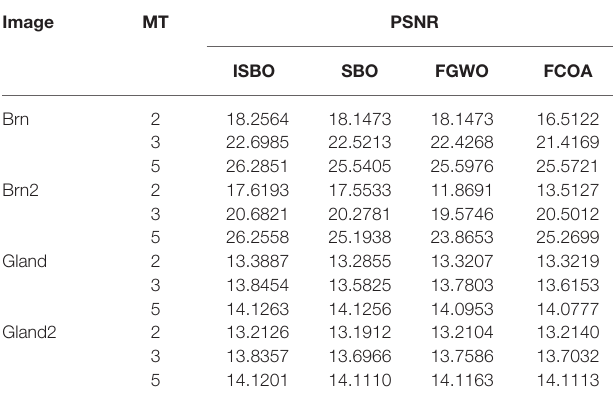
TABLE 7 | The experimental data with different algorithms.